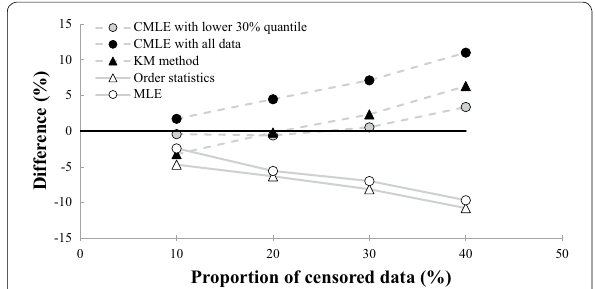
Fig. 5 Comparisons of statistics data analysis (dot: average value of thirty of 5th percentile